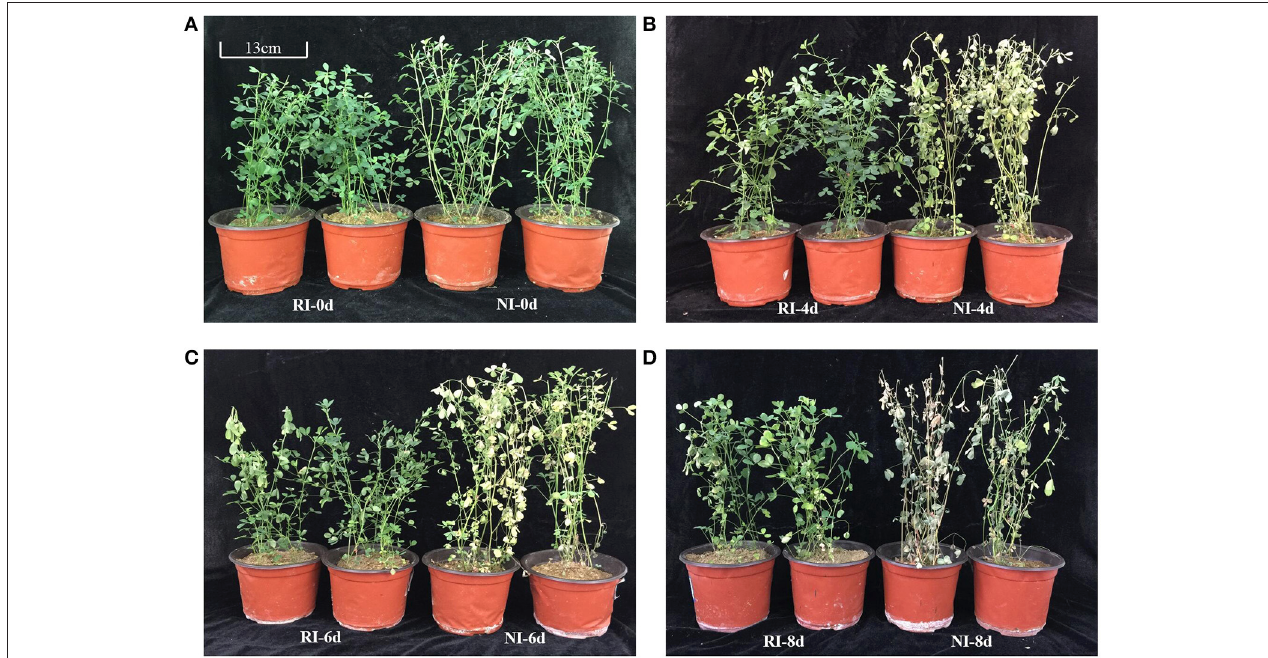
FIGURE 1 | Phenotype of alfalfa plants with or without rhizobium inoculation before and after NaHCO 3 treatment. (A) Untreated, (B) 4 d after alkali stress, (C) 6 d after alkali stress, and (D) 8 d after alkali stress. The left two pots in each image have inoculated RI group plants and the right two are non-inoculated NI plants.